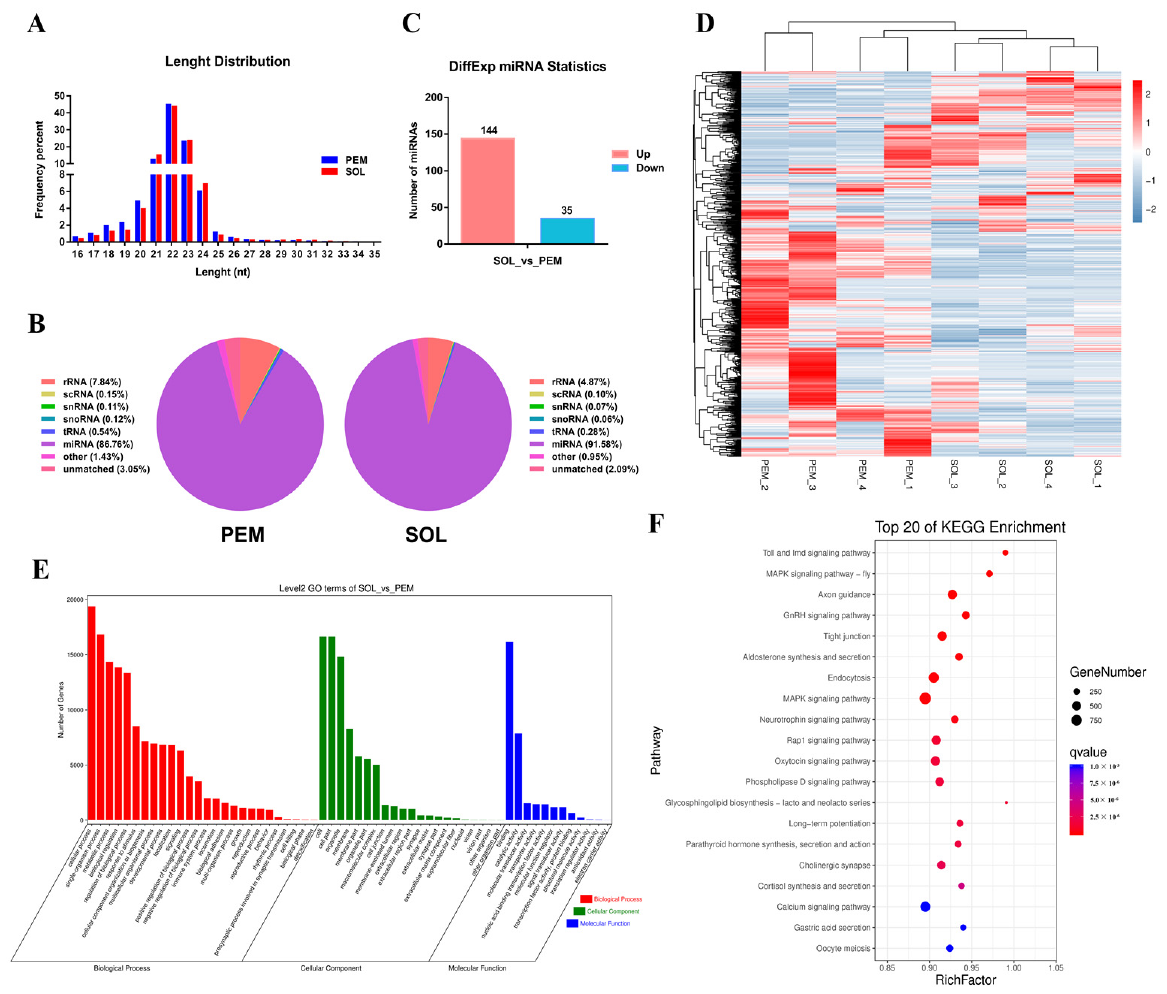
Figure 5. Small RNAs in pectoralis major and soleus of 7-week-old Xinghua chicken. ( A ), length, distribution, and abundance of small RNA sequences in pectoralis major (PEM) and soleus (SOL) of 7-week-old Xinghua chicken. ( B ), distribution frequency of small RNA sequences in different RNA categories. ( C , D ), statistics ( C ) and heatmap ( D ) of differentially expressed miRNA between PEM and SOL in 7-week-old Xinghua chicken. ( E , F ), GO functions ( E ) and KEGG pathways ( F ) analysis of the target genes of differentially expressed miRNAs.